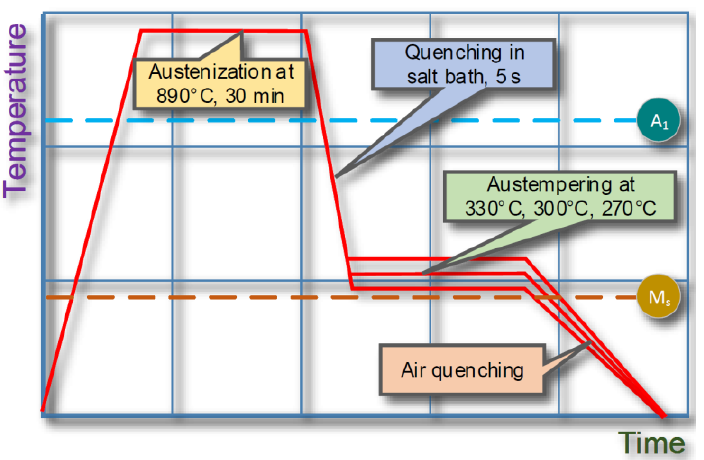
Figure 1. Schematic diagram of ductile cast iron aus-treatment cycle used in the present study (adapted from [27] Technologija, 2019). (adapted from [27] Technologija,